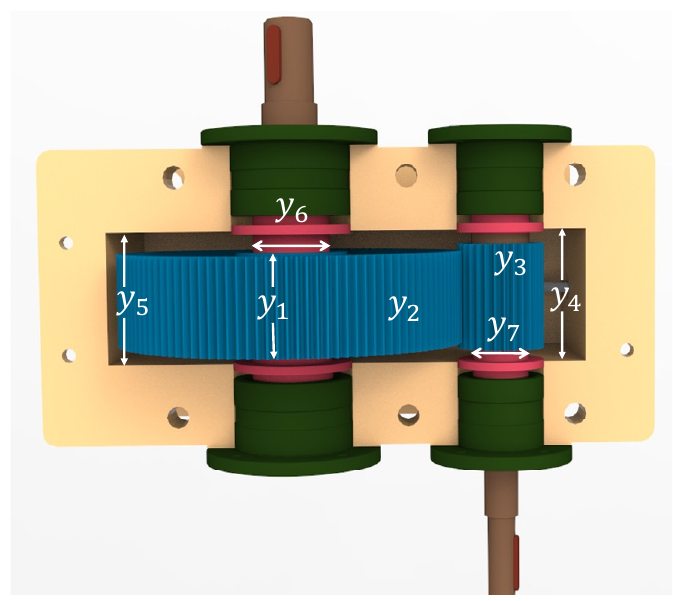
Figure 8. Speed reducer design problem.